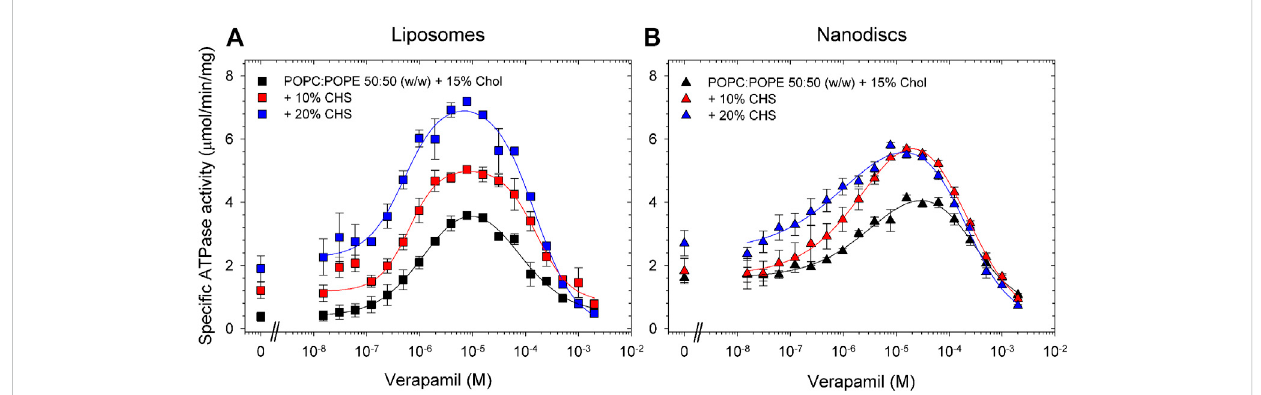
FIGURE 5 Effects ofCHSontheverapamil-stimulationofATPaseinproteoliposomes andnanodiscs.Puri fi edPgpwasreconstitutedinto (A) liposomes and (B) lipid nanodiscs containing POPC/POPE supplemented with 15% cholesterol and 0%, 10%, and 20% CHS. ATPase activity was measured as described in Experimental Procedures. Data points represent the mean ± SEM ( n = 3). In liposomes, more than 86% of Pgp ’ s NBDs were oriented inside-out and accessible to ATP hydrolysis as inferred from accessible to cleavage of the C-terminal Strep-tag, see Fig. S7.